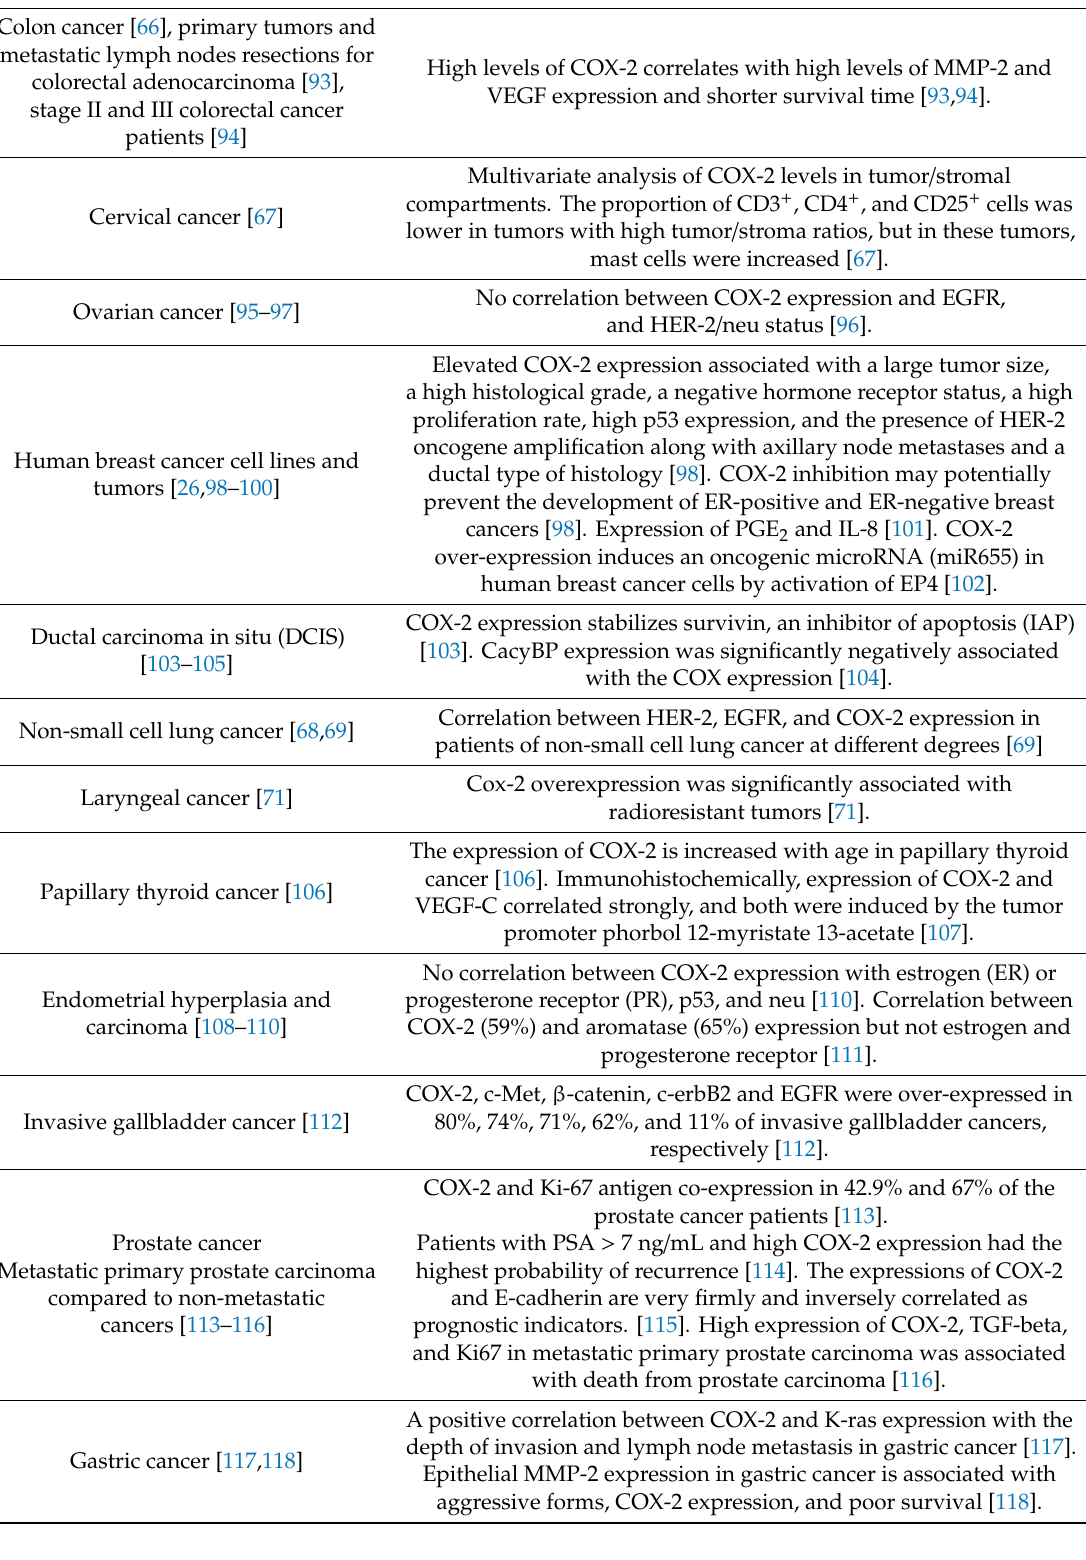
Table 1. Correlation between COX-2 level and other biomarkers found in tumoral tissues Tissue Location and Type of